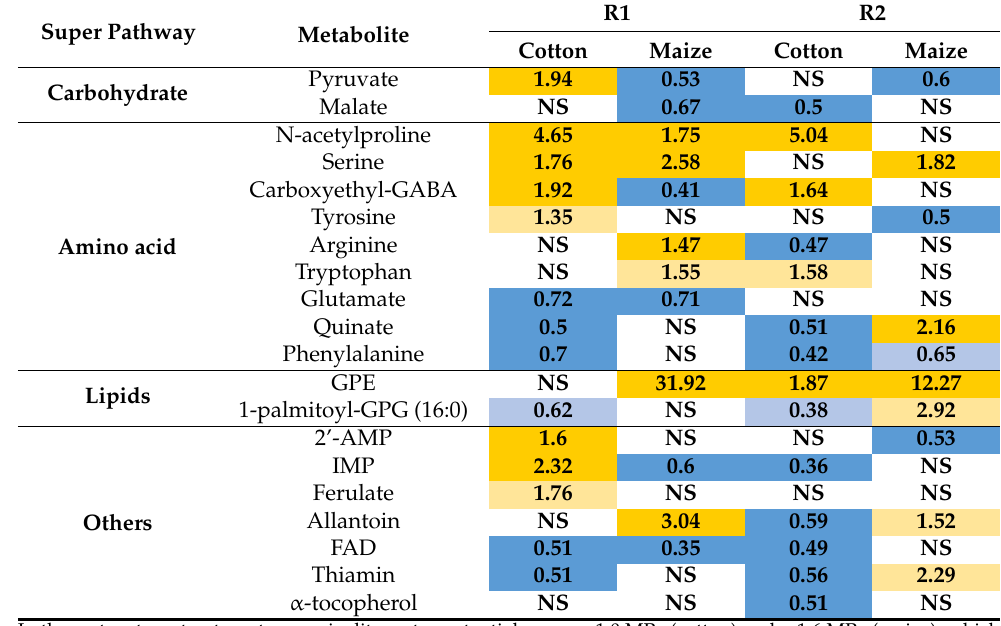
Table 2. Ratios of abundance of representative metabolites between water-stressed and well-watered primary roots of cotton and maize for metabolites showing specific responses in R1 or R2 of the elongation zone in at least one species.